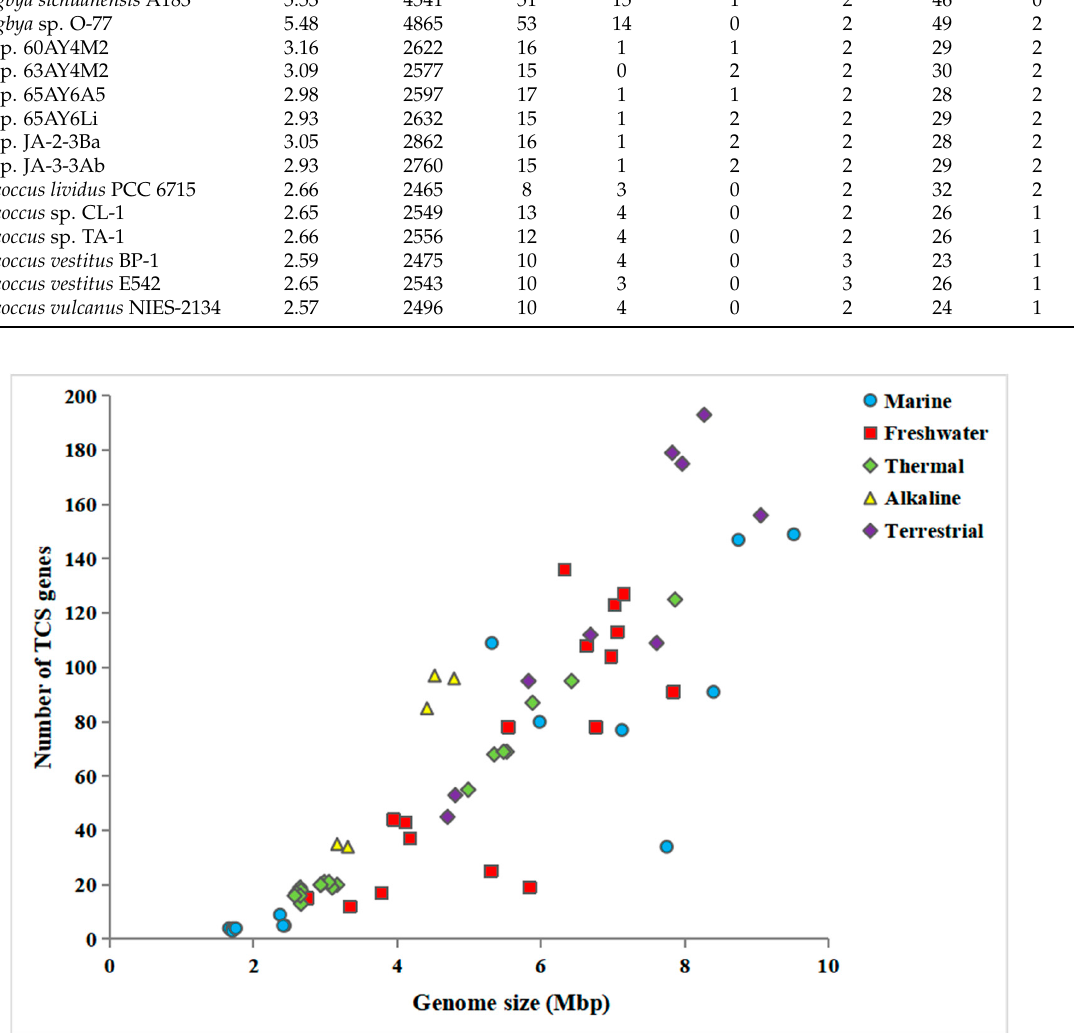
Figure 1. Correlation between TCS gene number and genome size.